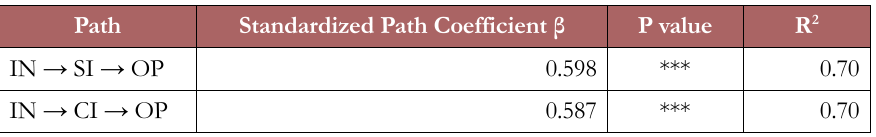
Table 5. Mediation of Supplier and Customer